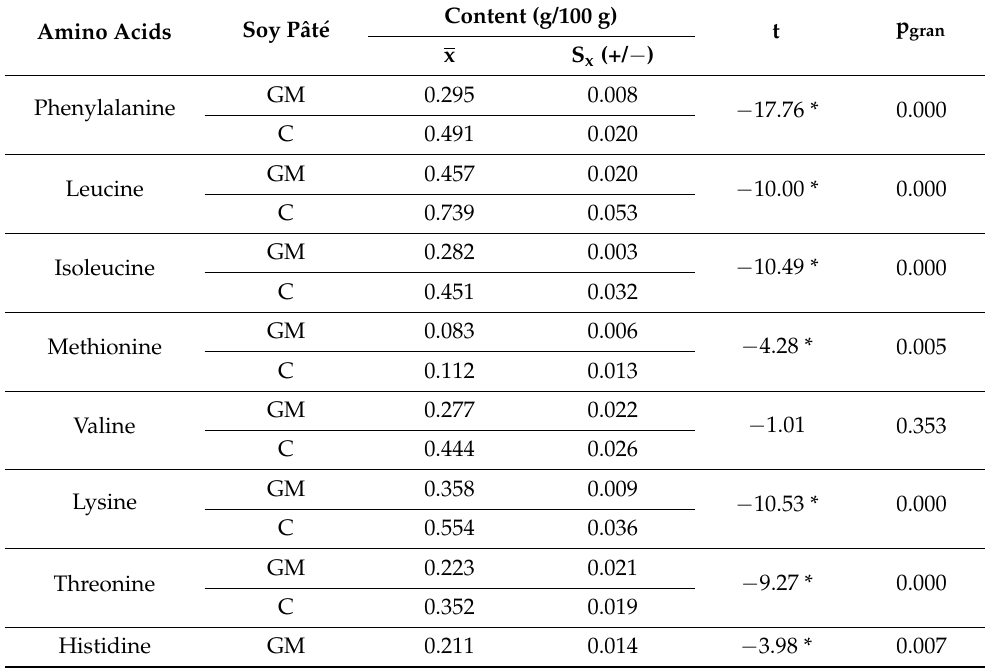
Table 3. Profile and content of exogenous amino acids in soy p â t é made from conventional and GM soybean